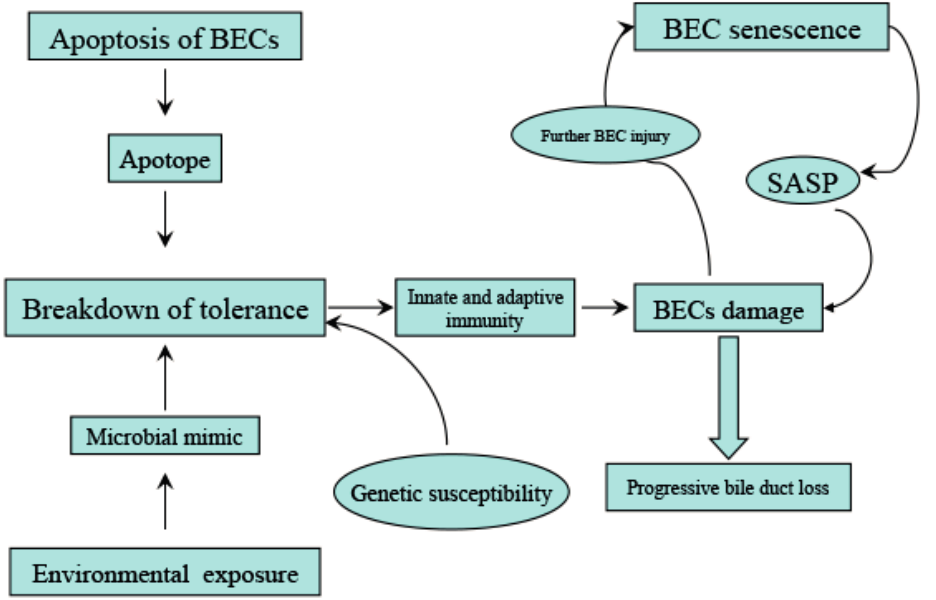
Figure 1. Microbial mimic can trigger the self-destructing immunopathogenic process in primary biliary cirrhosis (PBC). PBC-specific mitochondrial autoantigens remains structurally intact and retains its immunogenicity during biliary epithelial cell (BEC) apoptosis leading to the formation of apotope which can be recognized by circulating anti-mitochondrial autoantibody (AMA). The immune complex would stimulate innate and adaptive immunity in s subject with a susceptible genetic background. Progressive BEC damage tilts the balance between cellular injury and proliferative repair, leading to BEC senescence. The senescent BECs can secret a large amount of senescence-associated secretory phenotype (SASP) which may exert cytolytic response on the senescent cells and neighbouring cells. All of these processes can result in the progressive loss of bile ducts and liver